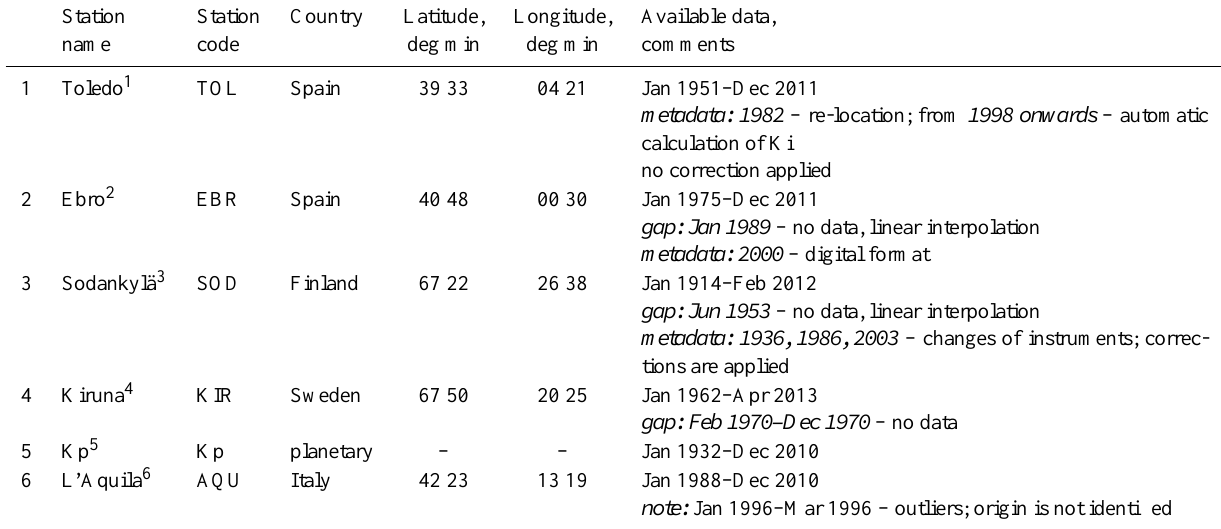
Table 2. A list of reference series used for COI Ki homogenization.